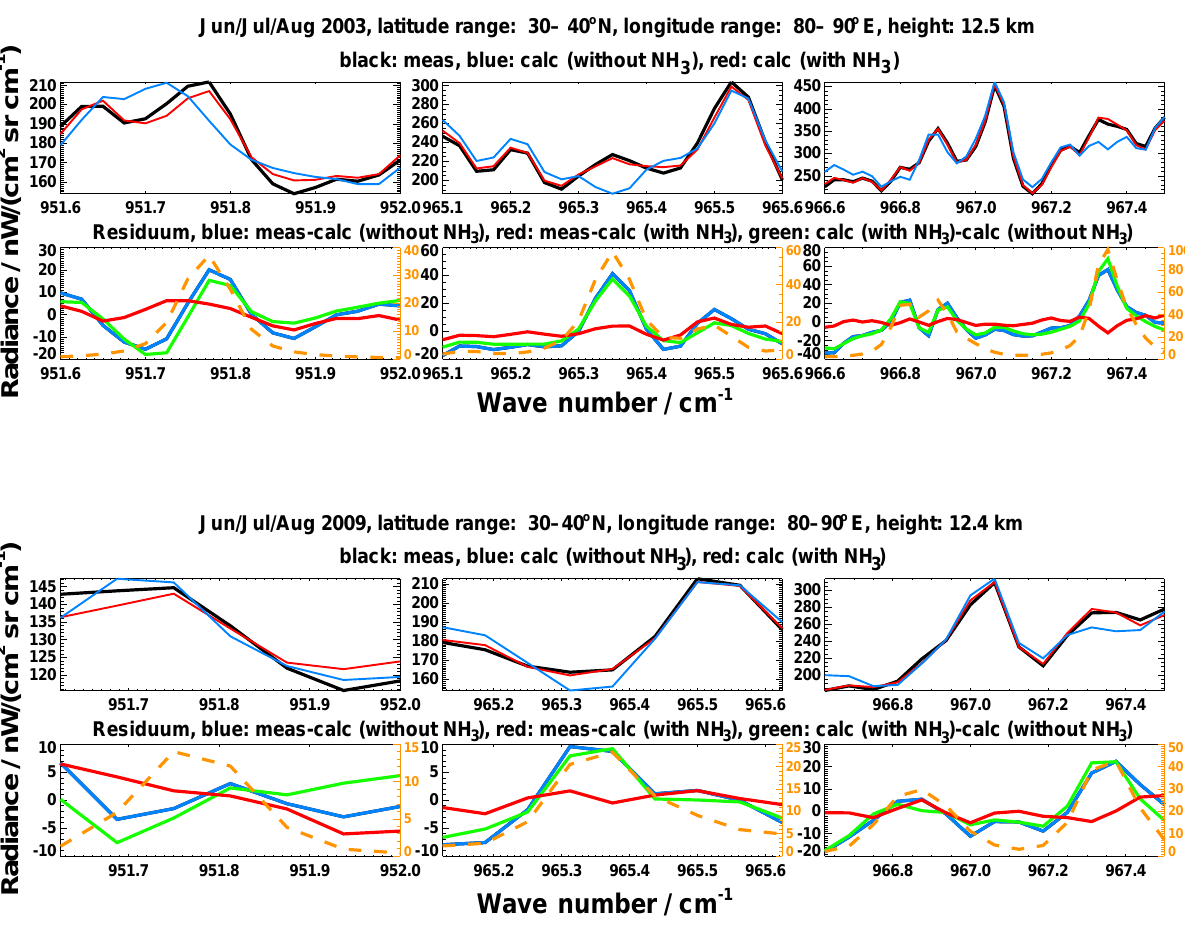
Figure 1. Spectral identification of NH 3 in MIPAS observations within the three spectral windows used for the retrieval (columns). The top two rows belong to the first observational period with higher spectral resolution. Rows 3 and 4 refer to the second period with lower spectral resolution. Rows 1 and 3 contain measured (black) and best-fit spectra (blue: without; red: with NH 3 ). Rows 2 and 4 show the spectral residuals without consideration of NH 3 (blue) and with NH 3 (red). Green curves in the second and fourth row represent the spectral features of NH 3 (calculation with NH 3 minus calculation without NH 3 ). To guide the eye, the orange dashed lines in rows 2 and 4 are simulated pure NH 3